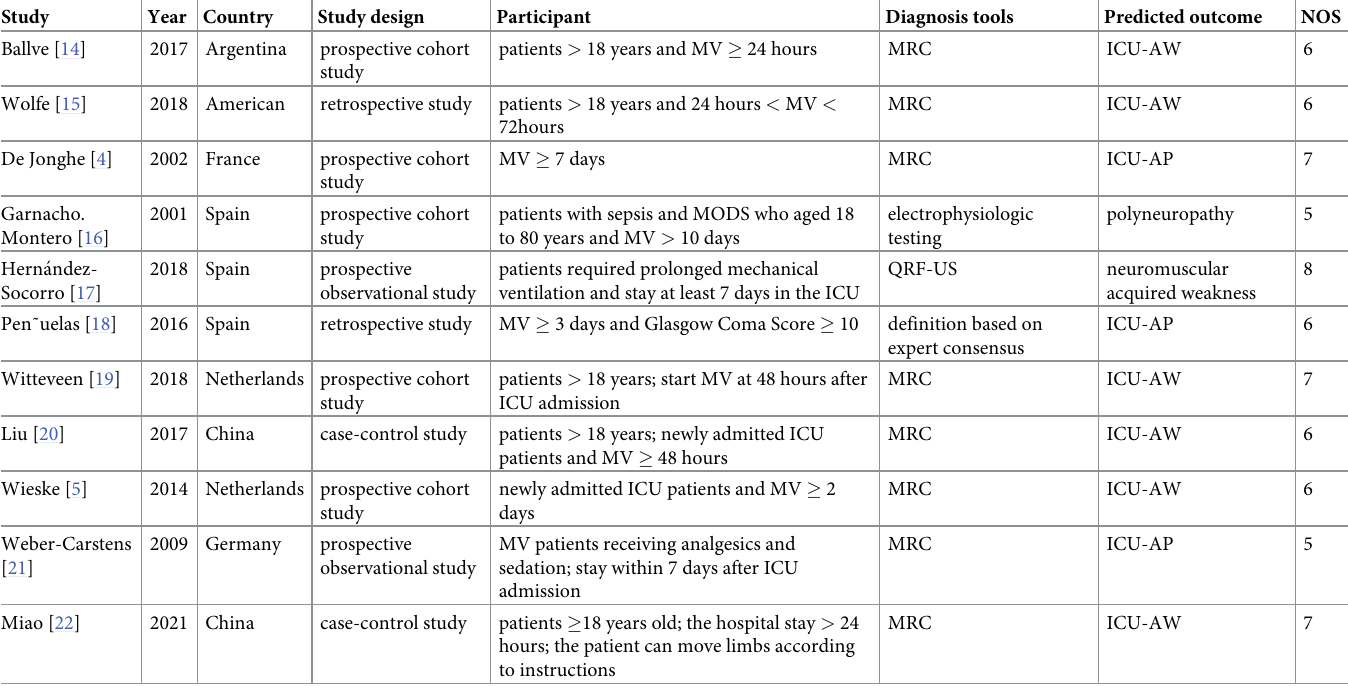
Table 1. Characteristics and quality of the included